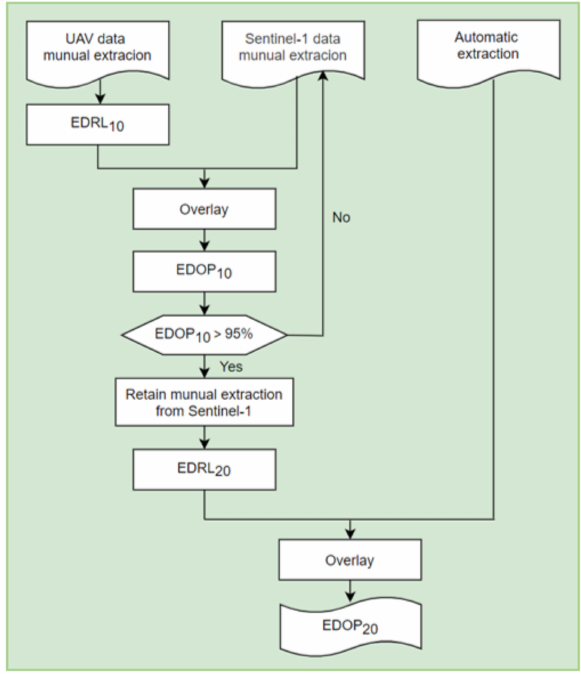
Figure 11. Proposed method of accuracy